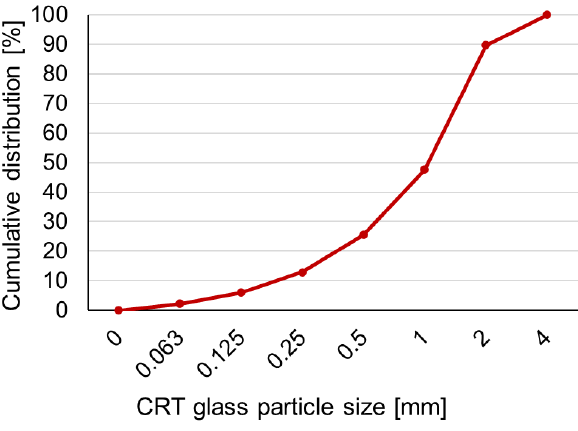
Figure 1. CRT glass particles size distribution.